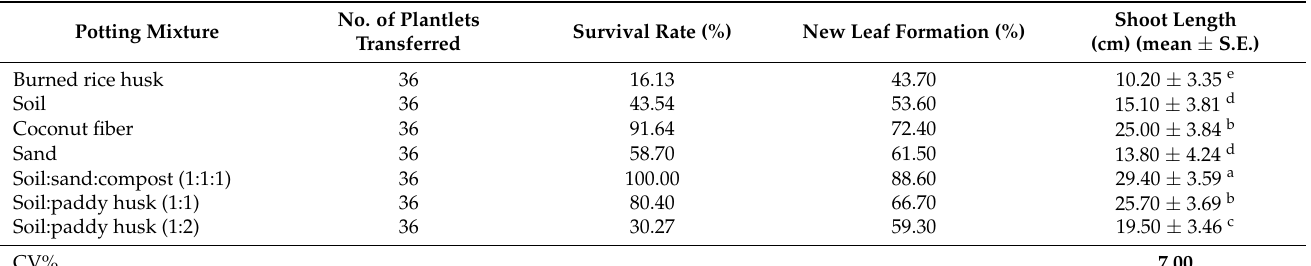
Table 4. Effect of various potting mixtures on hardening of in vitro rooted plantlets of S. thorelii Gagnep after 4 weeks.